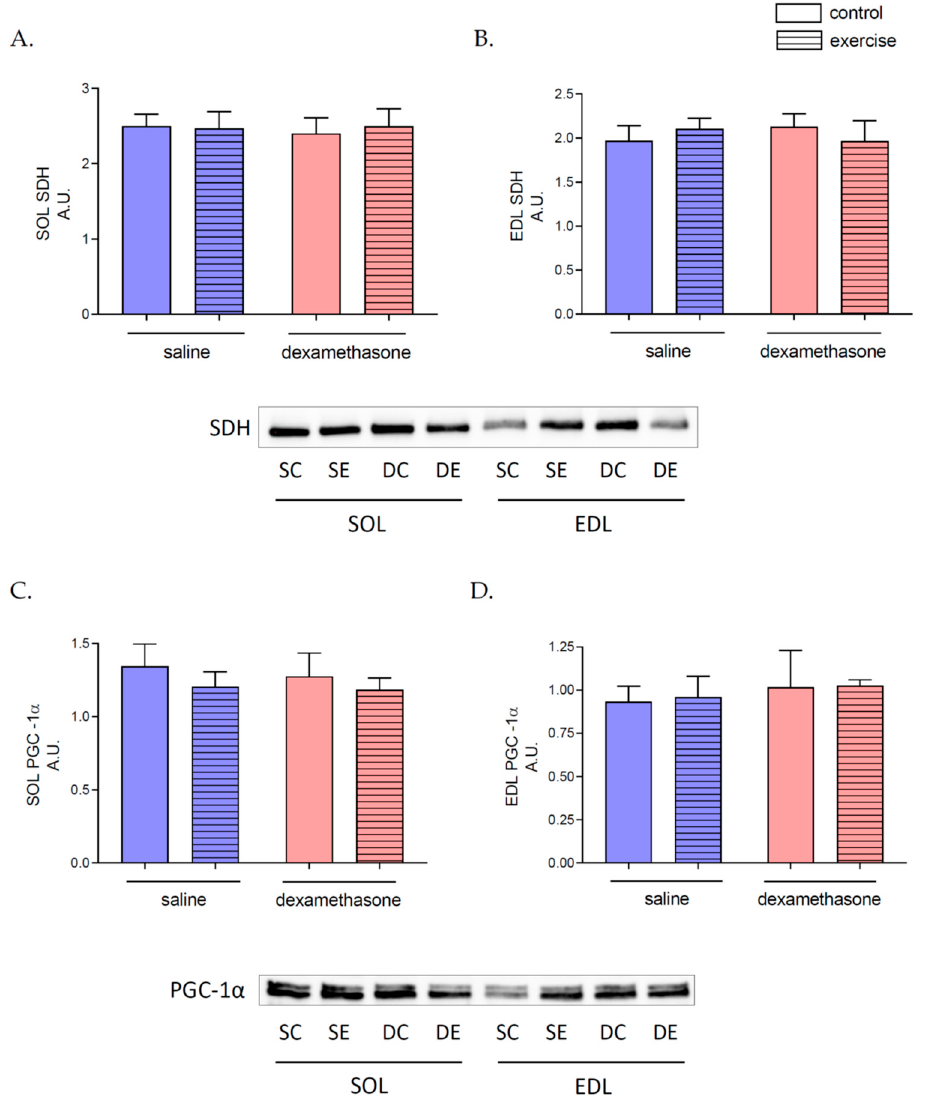
Figure 4. The effects of Dex treatment, swimming, and a combination of these factors on succinate dehydrogenase and peroxisome proliferator-activated receptor gamma coactivator 1-alpha levels in skeletal muscles. SOL succinate dehydrogenase (SDH) ( A ) and peroxisome proliferator-activated receptor gamma coactivator 1-alpha (PGC-1 α ) ( C ) levels, as well as EDL SDH ( B ) and PGC-1 α ( D ), were measured in skeletal muscles lysates in saline-treated, non-exercised (SC), saline-treated, exercised (SE), Dex-treated, non-exercised (DC) and Dex-treated, exercised (DE) groups of rats. Changes in protein levels were assessed by densitometry of the immunoreactive bands and normalized to the total amount of protein in the samples transferred onto the membrane (Figure S1). The data are presented as the means ± SEM ( n = 6 in each group).